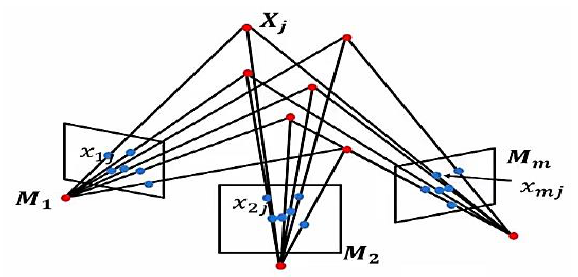
Figure 1. Schematic diagram of Structure from